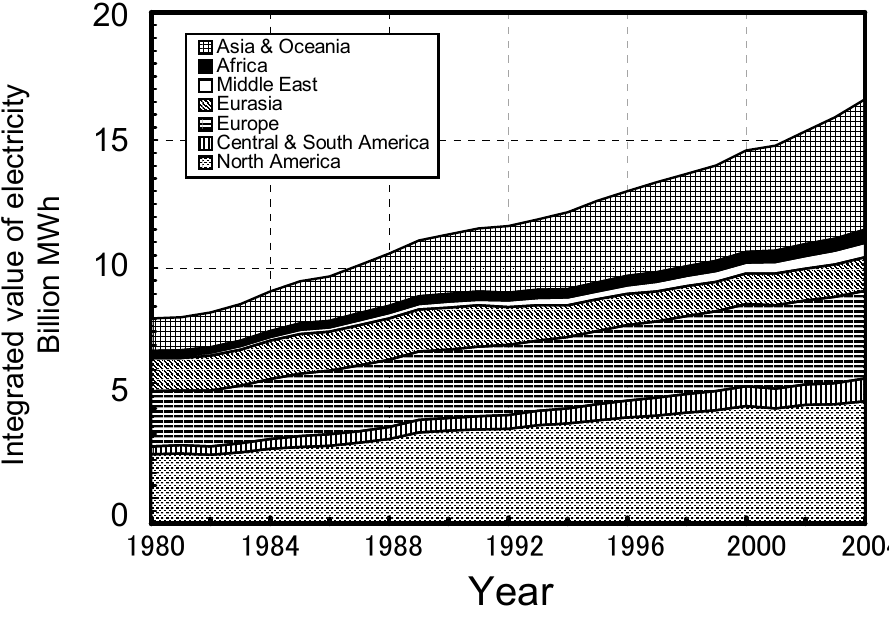
Figure 2. Time-line of world net electricity generation by region.